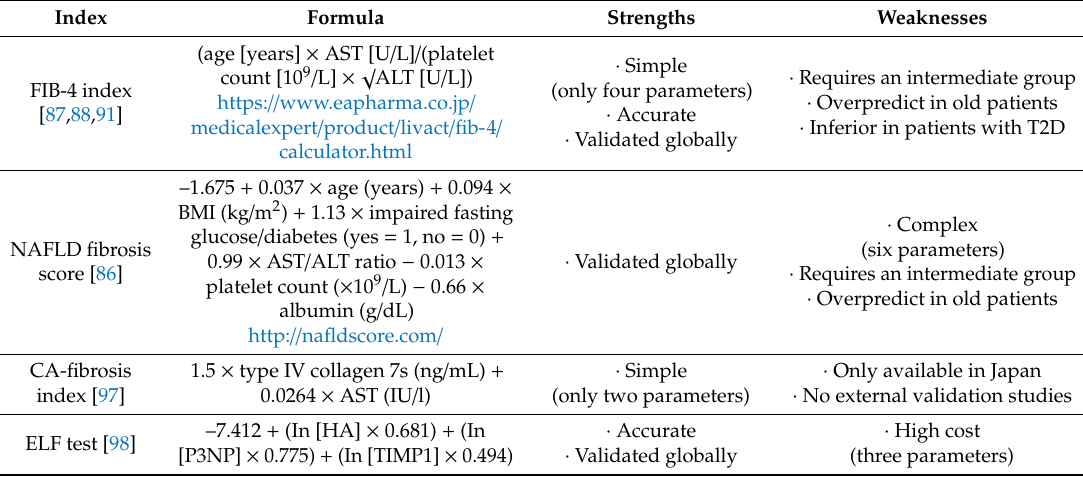
FIB-4: fibrosis-4, AST: aspartate aminotransferase, ALT: alanine aminotransferase, BMI: body mass index, HA: hyaluronic acid, P3NP: aminoterminal propeptide of type 3 procollagen. TIMP-1: tissue inhibitor of matrix metalloproteinase type 1, ELF: enhanced liver